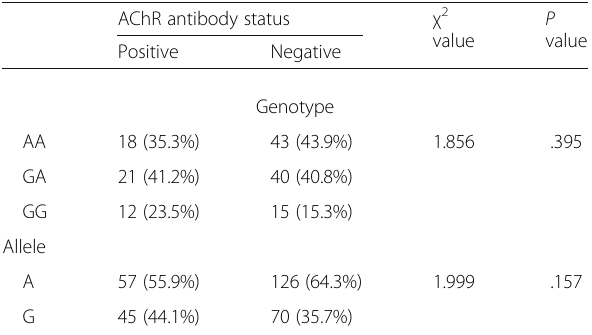
Table 5 Genotype and allele frequencies of BAFF rs2893321 in AChR antibody positive and AChR antibody negative patients with myasthenia